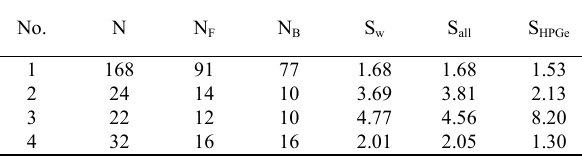
Results for the four described detector configurations. The number of total detectors is N, the numbers in the front and back part N F and N B , respectively. The scores S w and S all denote those with and without weighting, respectively.